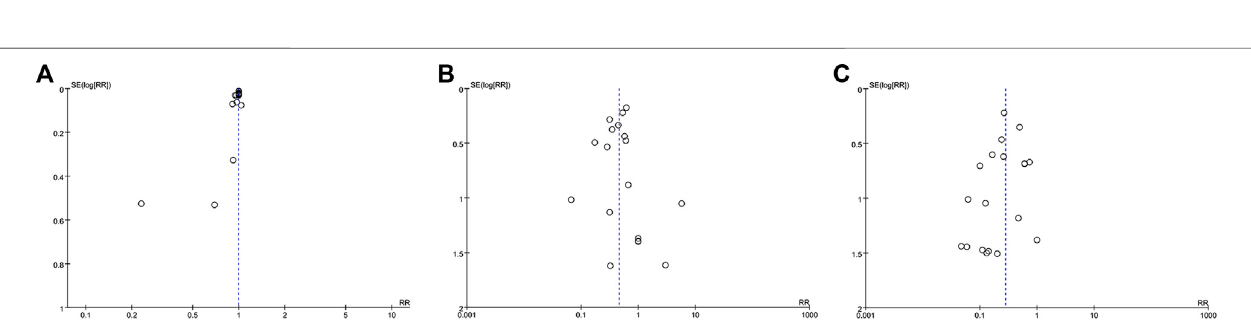
FIGURE 8 | Funnel plot (A) TCHM compared to routine drugs with the incidence of radiation dermatitis reported in 22 trails (B) TCHM compared to routine drugs with RTOG grading criteria reported in 20 trails (C) TCHM compared to conventional therapy with RTOG grading criteria reported in 19 trails.